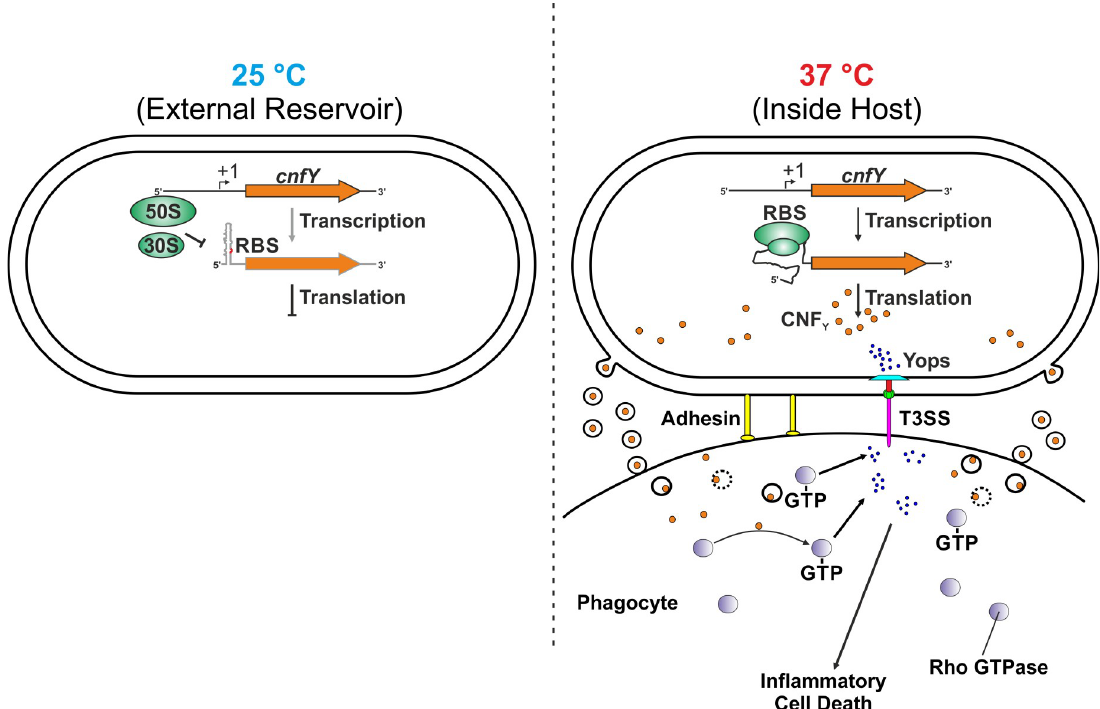
Fig 10. Model of two-layered cnfY thermoregulation in Y . pseudotuberculosis . At moderate temperatures (e.g. 25˚C), cnfY is weakly transcribed (S4 Table) and translation is hindered by a stem-loop structure in the 5’-UTR of cnfY . Within the host (37˚C), transcription is enhanced and the RNAT structure melts open, allowing translation of the cnfY transcript. During the infection process, the CNF Y toxin is secreted via outer membrane vesicles to the target host cells. Upon reaching the host target cell, the toxin is taken up by endocytosis and released into the cytosol due to a low pH-dependent mechanism. CNF Y then activates small Rho GTPases (RhoA, Rac1, and Cdc42) leading to increased pore formation of the T3SS and boosts Yop effector protein delivery into target cells. Additionally, caspase-1 is activated and triggers secretion of cytokines resulting in cell death due to inflammatory pyroptosis [20,21].